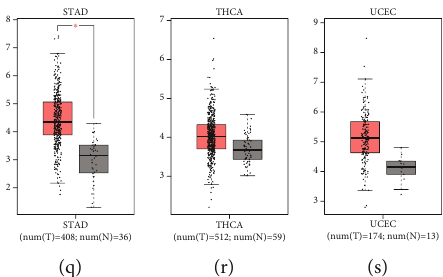
Figure 1: Expression analysis for LPCAT1 in multiple cancers. (a) The expression of LPCAT1 in 18 types of human cancer based on TCGA cancer and normal data. (b) – (m) The LPCAT1 expression in the GEPIA database. BLCA (b), BRCA (c), CHOL (d), COAD (e), ESCA (f), GBM (g), HNSC (h), KICH (i), KIRC (j), KIRP (k), LIHC (l), LUAD (m), LUSC (n), PRAD (o), READ (p), STAD (q), THCA (r), and UCEC (S) tissues compared with corresponding TCGA and GTEx normal tissues. ∗ p value < 0 : 05 ; ∗∗ p value < 0 : 01 ; ∗∗∗ p value < 0 : 001